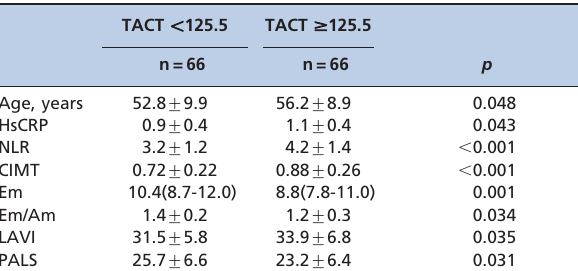
Table 4 - Comparison of clinical and echocardiographic variables between the inframedian and supramedian total atrial conduction times.